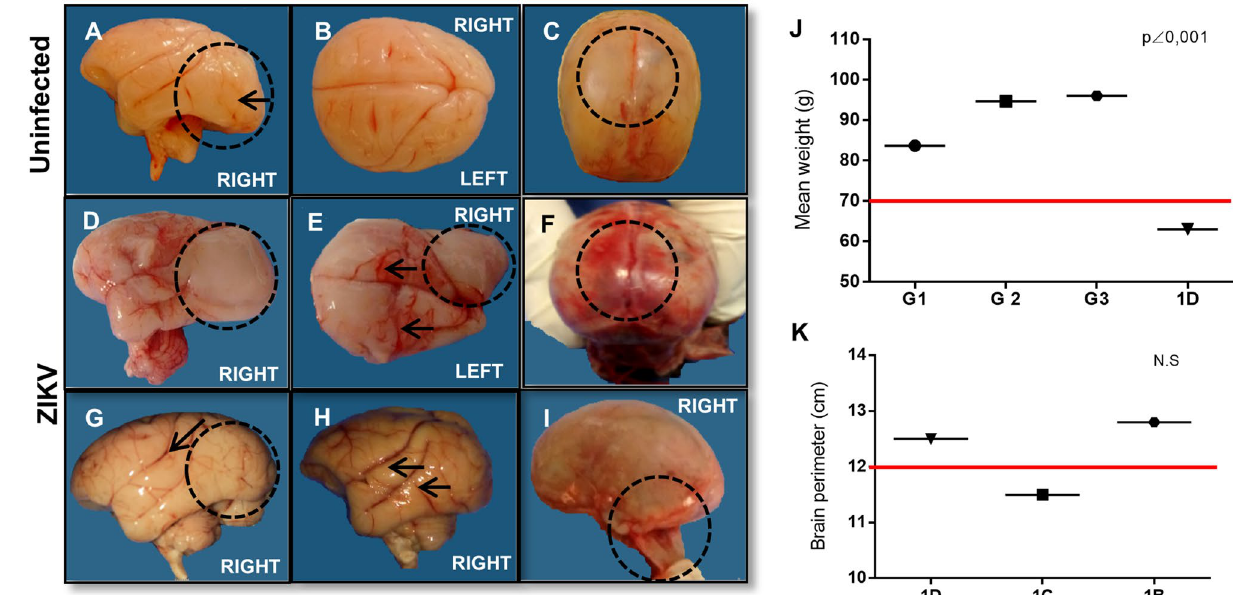
Figure 2. Macroscopic vascular impairment observed after autopsy and biometric differences in weight average and comparison of brain circumference. ( A – C ) Gross images of unfixed brain from G4 newborns (4A and 4D). ( A ) Image of right brain hemisphere of infants howing occipital gyrus (dashed black circle and black arrow). ( B ) Image of upper brain view showing normality of brain structures, presence of gyrus, and absence of vasocongestion. ( C ) The upper poster view of the skull, showing the integrity of the lambda, the point of union of the sagittal and lambdoid sutures, closing the occipital fontanelle (black arrow), absence of subarachnoid hemorrhage (dashed black circle). ( D ) Gross image of unfixed right brain hemisphere of newborn 1D (G1) showing lissencephaly, absence of occipital brain gyrus (dashed black circle), ventriculomegaly, and prolongation of the right occipital hemisphere. ( E ) Gross image of unfixed right brain of newborn 1D showing ventriculomegaly of the occipital hemisphere (dashed black circle), right side, absence of superior occipital gyrus (dashed black circle), and vasocongestion on both sides of upper view (black arrows). ( F ) Gross image of unfixed upper poster view of the skull showing Lambda malformation with no closure of the sagittal and lambdoid sutures (black arrow), and extensive subarachnoid hemorrhage (black dotted circle). ( G ) Gross image of unfixed right hemisphere of the newborn 1C (G1) brain showing lissencephaly, absence of occipital brain gyrus (dashed black circle), and vasocongestion in brain veins (black arrow). ( H ) Gross image of right brain hemisphere of newborn 1B (G1) showing vasocongestion in cerebral veins (black arrows); ( I ) crude image of the lateral view of the skull of the newborn 1D, showing lambda malformation with no closure of the sagittal and lambdoid sutures (dashed black circle; ( J ) T-test graph of means (99%) and standard deviation comparing the weight averages of the groups (G1, G2 and G3) with that of newborn 1D, the red line indicates the population mean (89.17 g); ( K ) T-test graph of means (99%) and the standard deviation comparing the brain perimeters of the newborns of group1, the red line indicates the population average (12